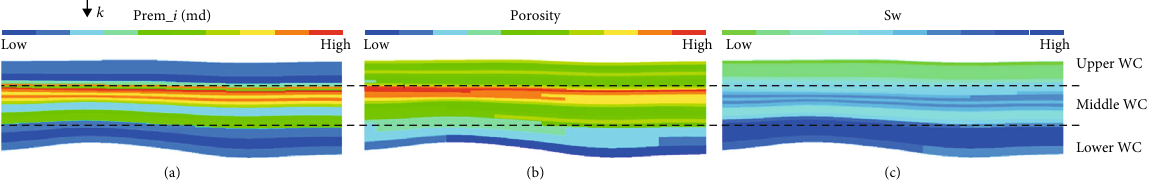
Figure 4: Reservoir model j - k cross-section: (a) permeability, (b) porosity, and (c) water saturation.